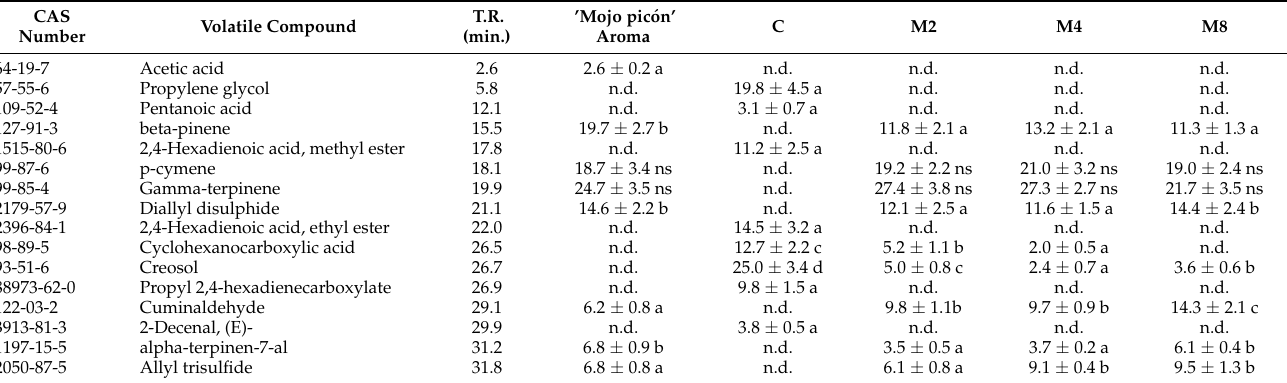
C: Spanish-style green table olives without aroma; M2: Spanish-style green table olives with ‘Mojo pic ó n’ aroma at 2%; M4: Spanish-style green table olives with ‘Mojo pic ó n’ aroma at 4%; M8: Spanish-style green table olives with ‘Mojo pic ó n’ aroma at 8%. RT = retention time. n.d.: not